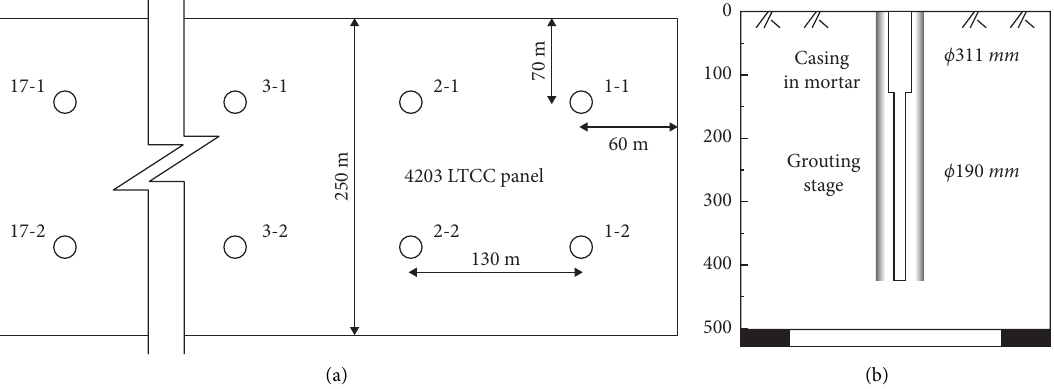
Figure 11: Grouting borehole arrangement and borehole structure. (a) Grouting borehole arrangement. (b) Borehole